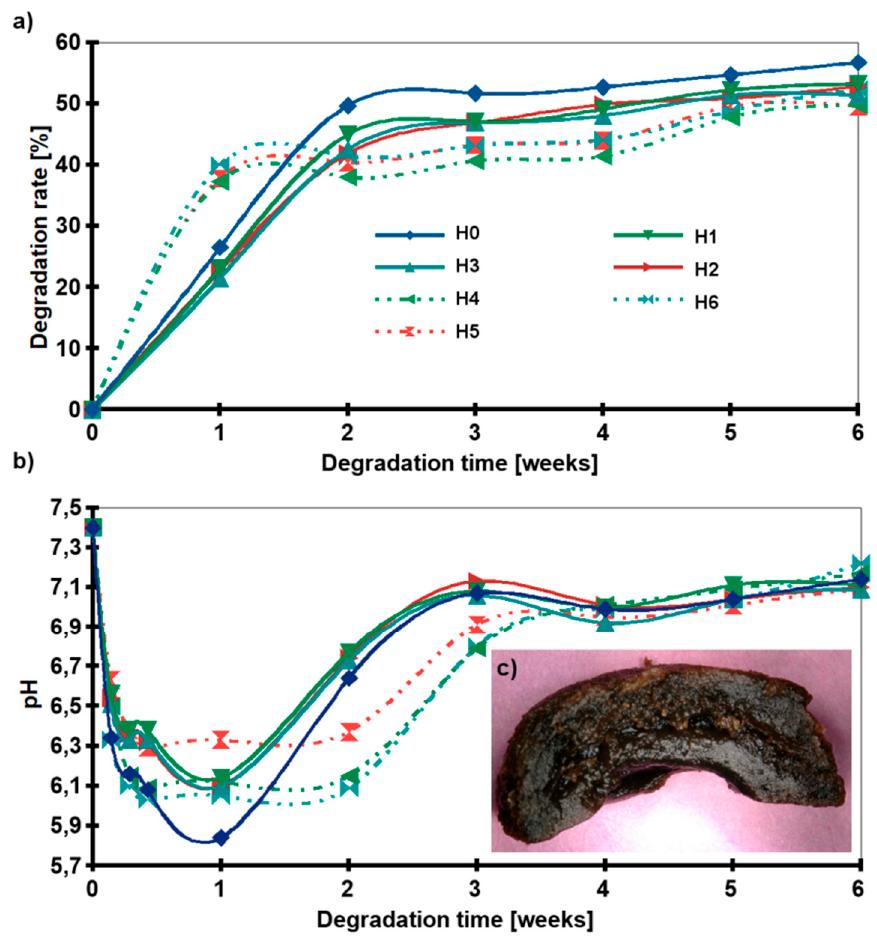
Figure 7. Degradation behavior: ( a ) Weight loss of the samples as a function of incubation time in PBS, ( b ) pH of media, ( c ) Digital microphotograph of H2 after 6 weeks of incubation (slice cut in half); (H0: chitosan (CS); H1: CS / graphene oxide (GO); H2: CS / poly(ethylene glycol) grafted graphene oxide (GO-PEG); H3: CS / reduced graphene oxide (rGO); H4: CS / GO / hydroxyapatite (HAp); H5: CS / GO-PEG / HAp; H6: CS / rGO / HAp).